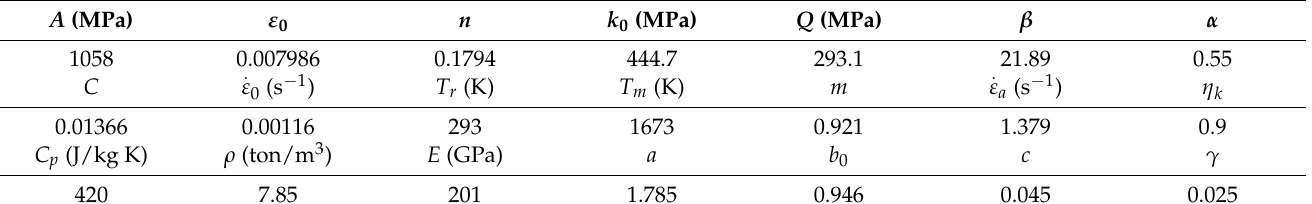
Table 2. Material model parameters used in ship collision analysis.